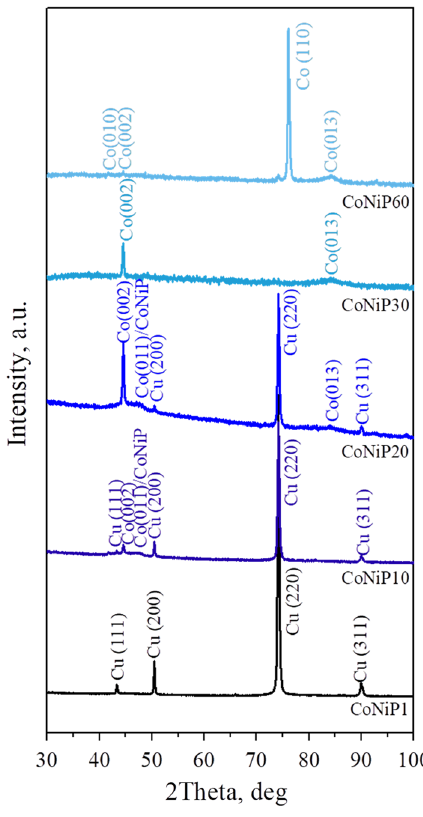
Figure 1. Diffractograms of coatings applied during 1, 10, 20, 30, and 60